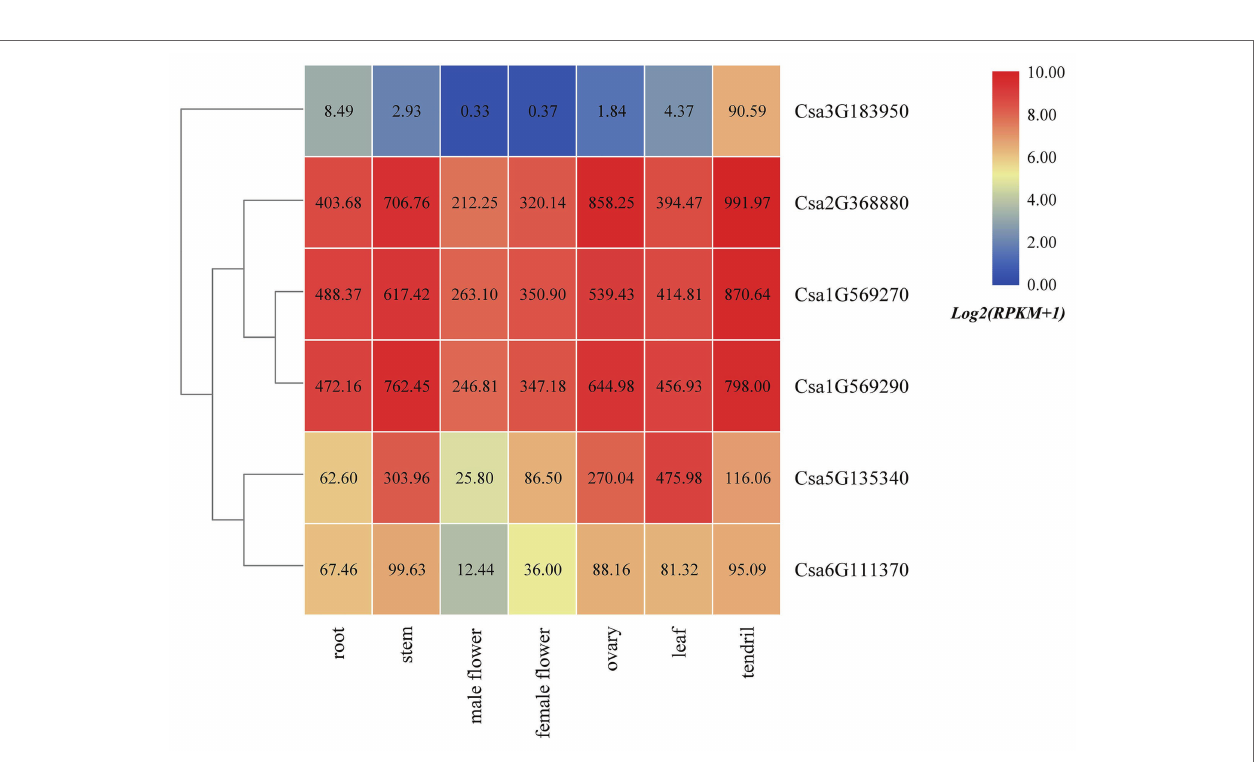
FIGURE 5 | The expression heatmap of the HSP90 gene family in different tissues of cucumber. The data in the boxes indicate original RPKM